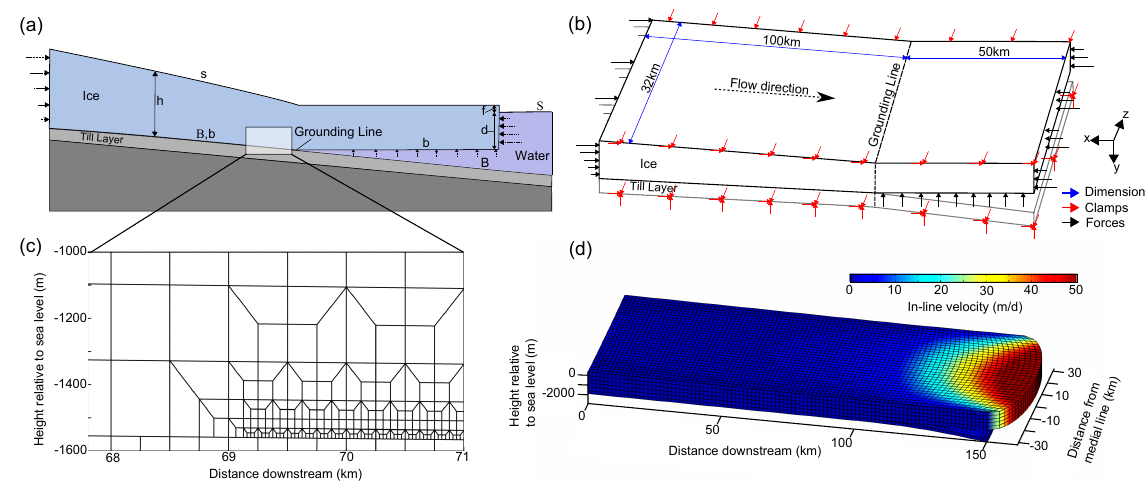
Figure 1. Model setup for 2-D (a, c) and 3-D (b, d) simulations. Panels (a) and (b) are schematic representations of the model domains while (c) and (d) show the model grid (panel (c) is zoomed in to show refinement near the grounding line). The 3-D grid in (d) has been vertically exaggerated by a factor of